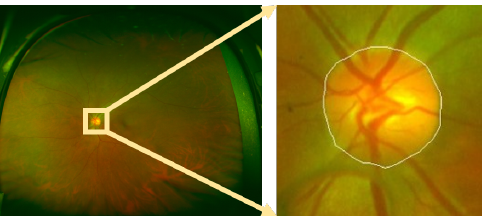
Figure 20. An example of the TMUEH dataset: (left to right) original fundus image and the GT of the OD boundary.